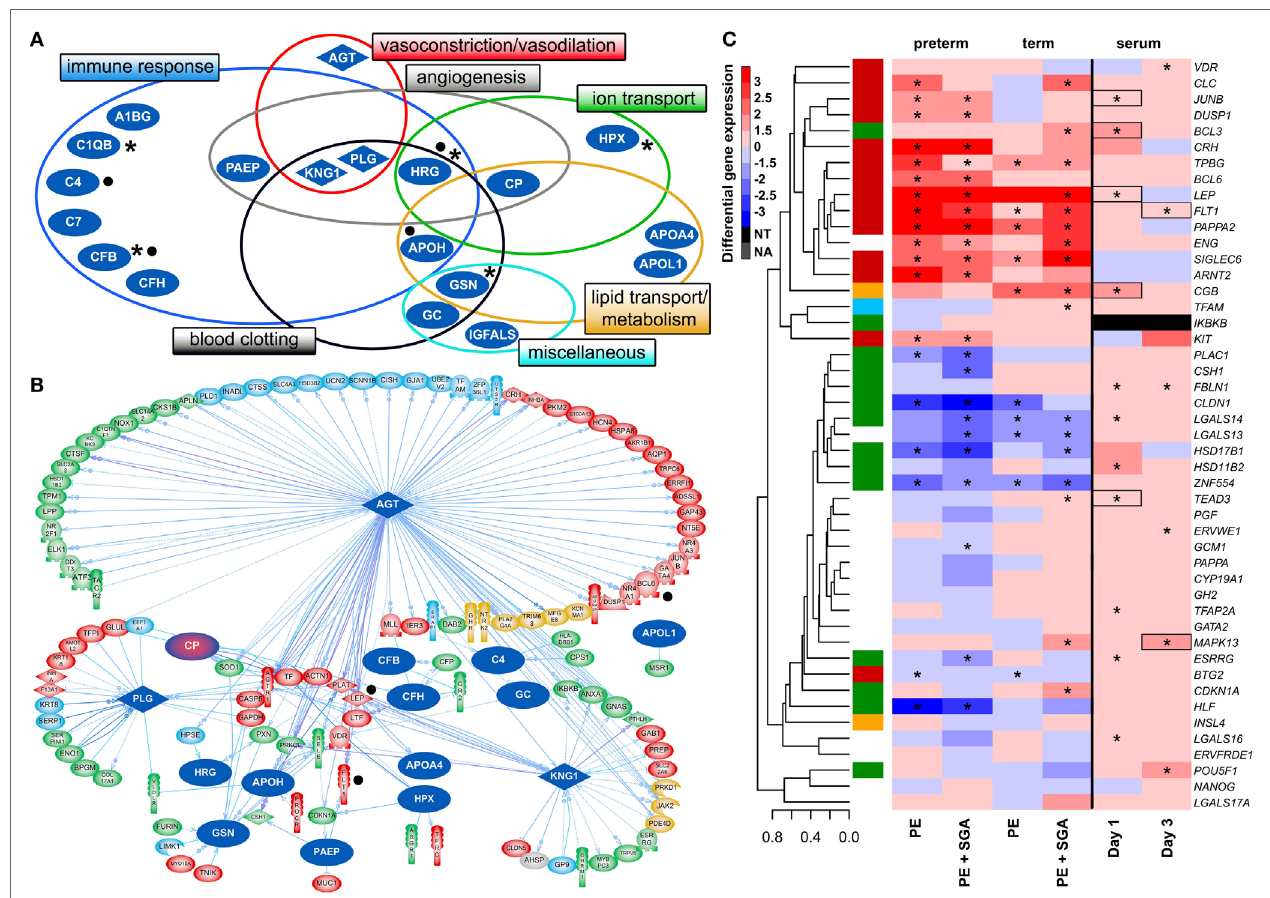
FigUre 6 | Maternal blood proteomic changes and their effect on differentially expressed (DE) genes in preterm preeclampsia. (a) The 19 DE maternal serum proteins in preterm preeclampsia identified by two-dimensional differential in-gel electrophoresis could be classified into functional groups relevant for preeclampsia pathophysiology. Asterisks denote proteins reported by others to have the same direction differential abundance in the first trimester in patients developing preterm preeclampsia (126, 143, 239–241). Dots denote immune proteins that multiple reaction monitoring assays identified to have differential abundance in preterm preeclampsia in the same direction. (B) The 19 DE serum proteins have connections to 121 DE placental genes, among which 48 belong to module M2. Angiotensinogen has more connections than other proteins (OR = 1.9, p = 4.9 × 10 − 5 ), and the most connections to module M2 genes ( n = 35); 77 of 86 connections of angiotensinogen have a directional effect toward the gene. Dots denote genes in connection to angiotensinogen found up-regulated in villous trophoblast (VT) upon treatment with first trimester serum from preeclamptic women. (c) Hierarchical clustering tree and heatmap representing differential placental gene expression in preeclampsia as in Figure 4a . The expression of the same genes (except IKBKB ) was determined in primary VTs upon treatment with first trimester maternal serum. Serum from preeclamptic compared to control women induced the up-regulation of seven placental dysregulated genes (depicted with boxes) on the first and third days of VT differentiation, among which six were up-regulated in term and three in preterm preeclampsia. Stars depict significant changes, color bar encodes signed (up or down)-fold changes. Abbreviations: NA, not expressed; NT, not